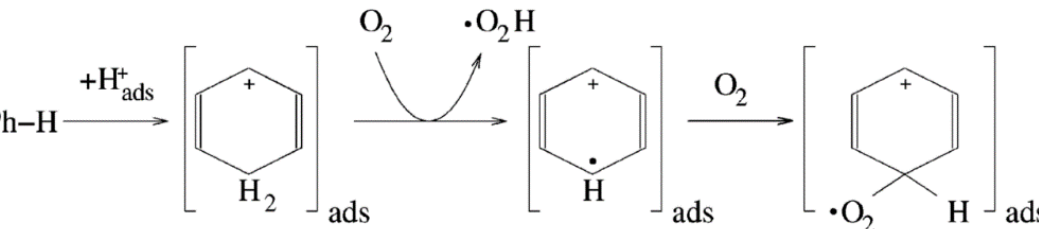
Figure 14. Carbocation mechanism for the reaction of oxygen with an adsorbed coke molecule (presented by Dong et al. [116] and adapted by Keskitalo et al. [102]).